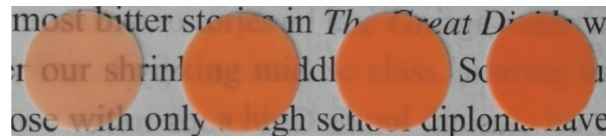
Figure 9: Red phosphor films with different concentrations (weight ratios phosphor: silicone = 0.05:1; 0.1:1; 0.15:1; 0.2:1).